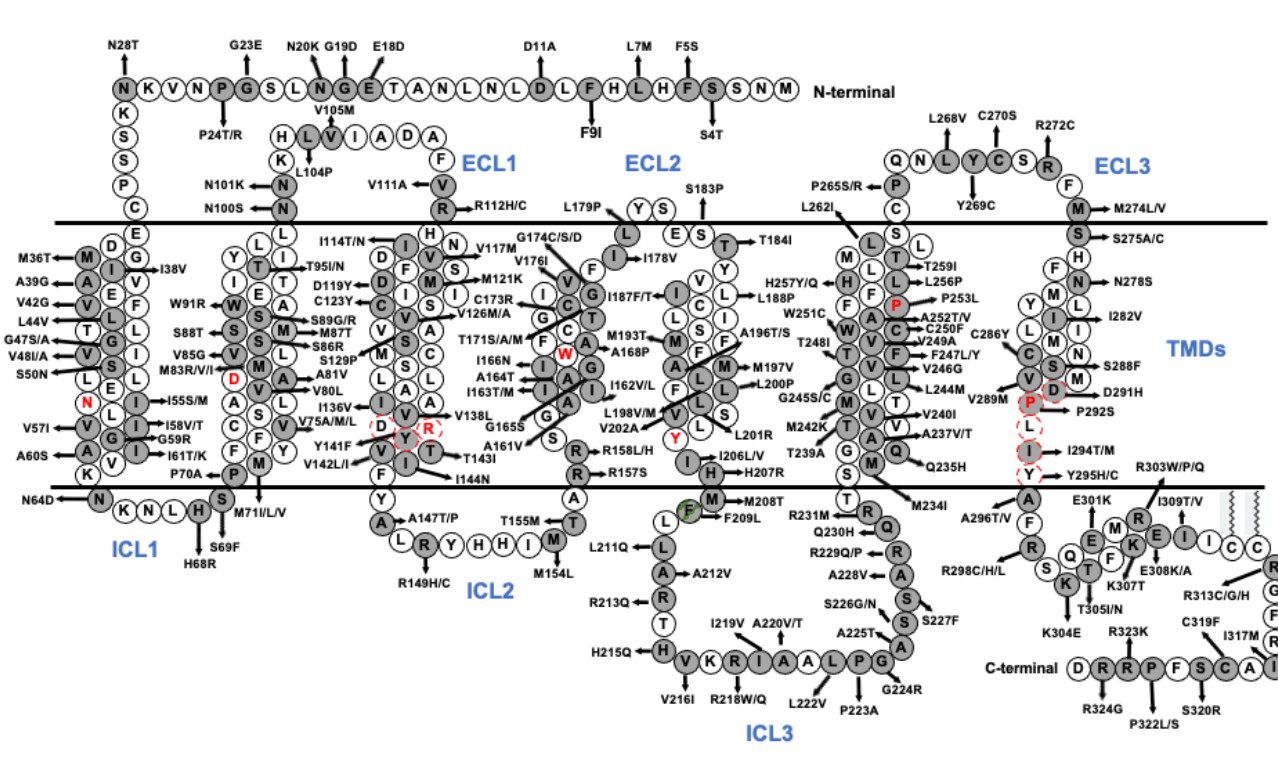
Figure 2. Naturally occurring human MC5R mutations recorded in gnomAD database v2.1.1 (https://gnomad.broadinstitute.org/ (accessed on 13 April 2022)). The circles with gray background are missense and nonsense mutations/polymorphisms. Frameshift mutations are not shown here. The polymorphism (F209L) is labeled with a circle filled with red dashed lines. The most conserved residues in transmembrane domains (TMDs) are denoted in red font. DRY and DPxxY motifs are labeled in dashed line circles. MC5R secondary structures with extracellular loops (ECLs), transmembrane domains (TMDs), and intracellular (ICLs) loops are denoted in blue font.